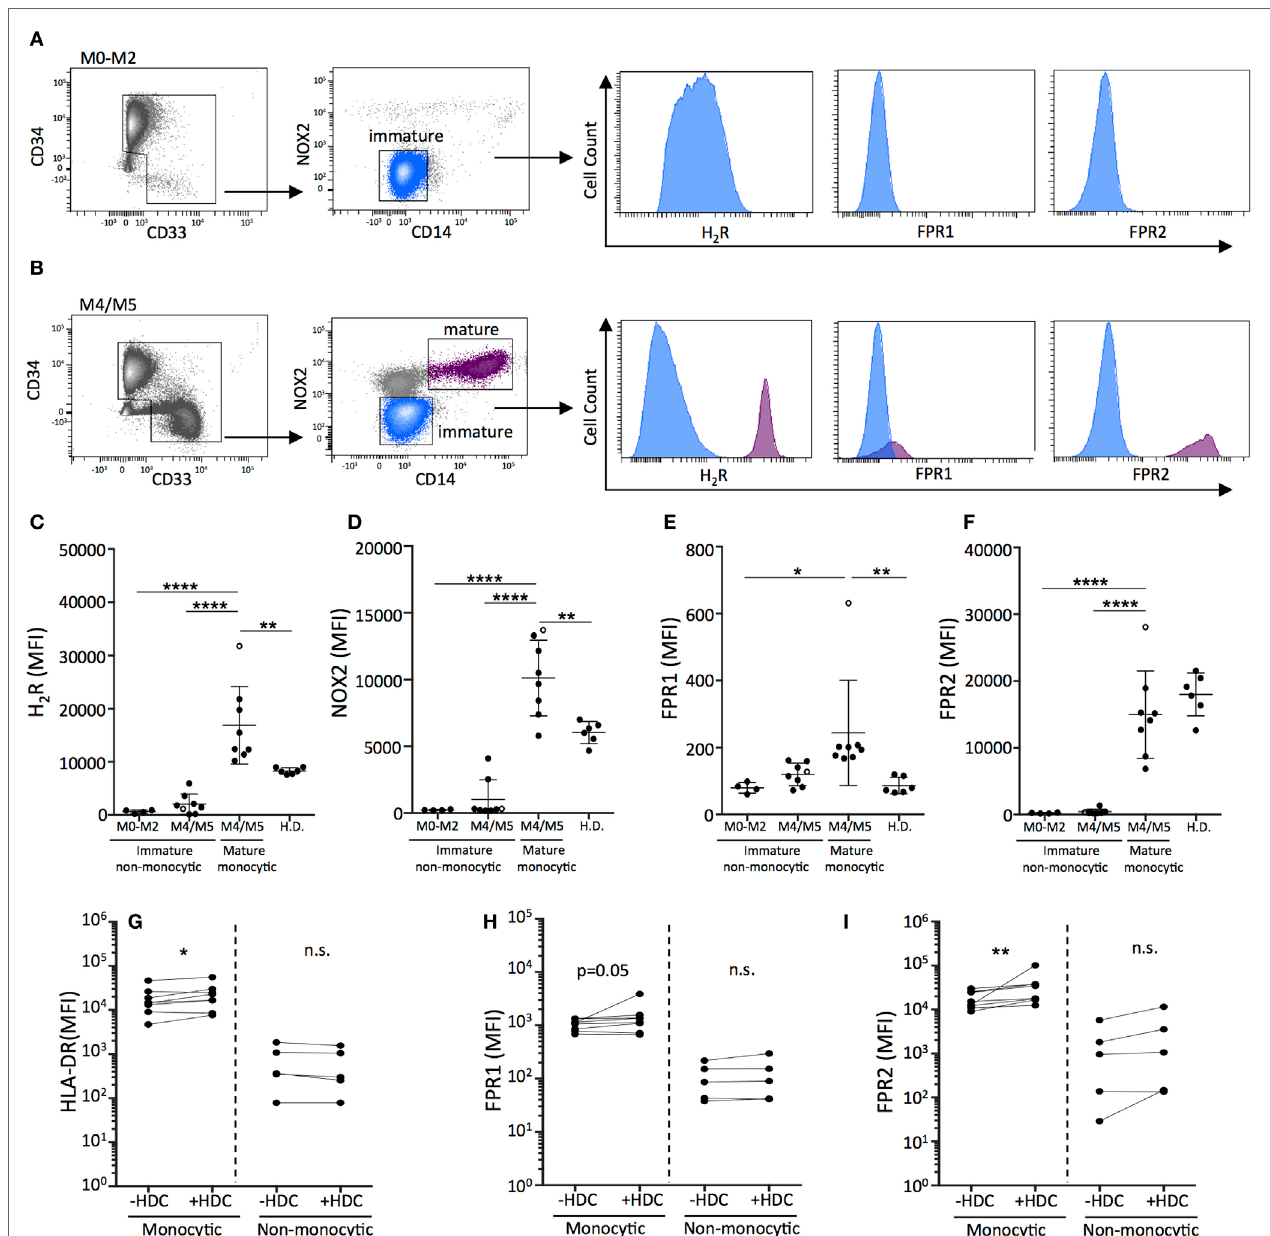
FigUre 4 | Histamine dihydrochloride (HDC) facilitates the differentiation of monocytic primary leukemic cells and may be preferentially efficacious in monocytic forms of leukemia. FACS-plots showing live peripheral blood mononuclear cells from representative newly diagnosed patients with (a) FAB-M0 acute myeloid leukemia (AML) with a dominant immature leukemic population (CD34 + CD33 − CD14 − ) and (B) FAB-M4 AML with two distinct populations: an immature blast population (CD34 + CD33 − CD14 − ) and a mature monocytic population (CD34 − CD33 + CD14 + ). The expression of (c) H 2 R, (D) NOX2, (e) FPR1, and (F) FPR2 on primary AML cells [gated as indicated in (a,B) ] and monocytes from healthy donors was determined by flow cytometry. The M5 leukemia is represented by an open circle. One-way ANOVA. (g–i) Median fluorescence intensity as determined by flow cytometry of (g) HLA-DR, (h) FPR1, and (i) FPR2 on live primary monocytic AML cells (FAB: M4/M5) or non-monocytic AML cells (FAB: M0–M2) cultured for 5 days with GM-CSF/IL-4 in the presence or absence of HDC. Wilcoxon matched pair’s test. * p < 0.05, ** p < 0.01, *** p < 0.001, **** p <